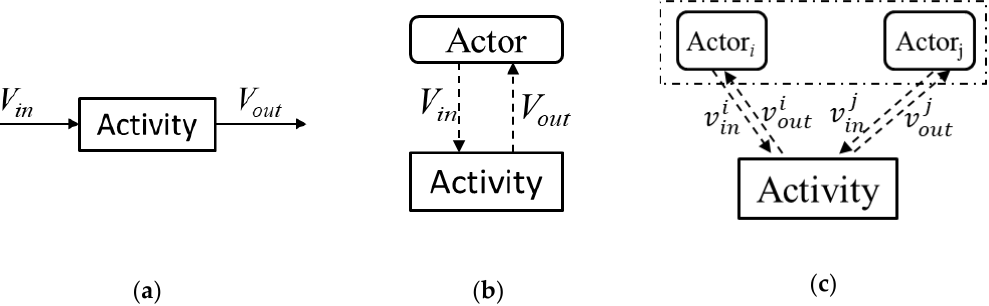
Figure 6. Value of activity. ( a ) Each activity has an input value and an output value; ( b ) each actor has an input value and an output value on the activity; ( c ) multiple actors work together to complete the activity.